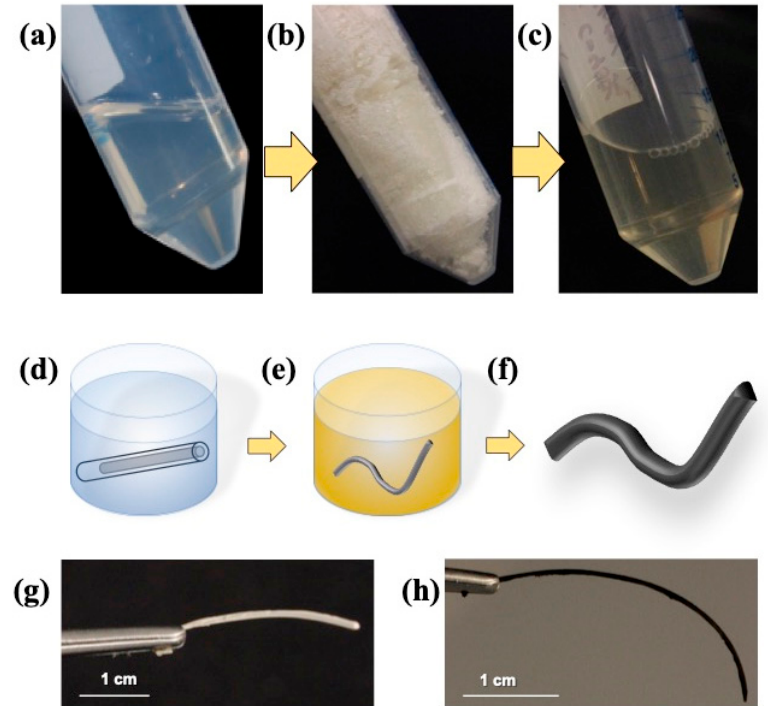
Figure 1. Silk fibroin aerogel fiber synthesis scheme. Different working solutions of silk fibroin starting with ( a ) regenerated silk fibroin solution, ( b ) lyophilized silk fibroin, and ( c ) hexafluoro-2-propanol (HFIP)–silk fibroin. Scheme depiction of the synthesis of noble metal silk fibroin aerogel fibers. ( d ) HFIP–silk fibroin in silicon tubing mold in an ethanol bath to induce physical crosslinking, ( e ) equilibrating in noble metal ionic solution, and ( f ) after reduction and supercritical drying. ( g ) The silk fibroin aerogel fiber without noble metal addition and ( h ) the silk–palladium aerogel fiber (scale bars are 1 cm).